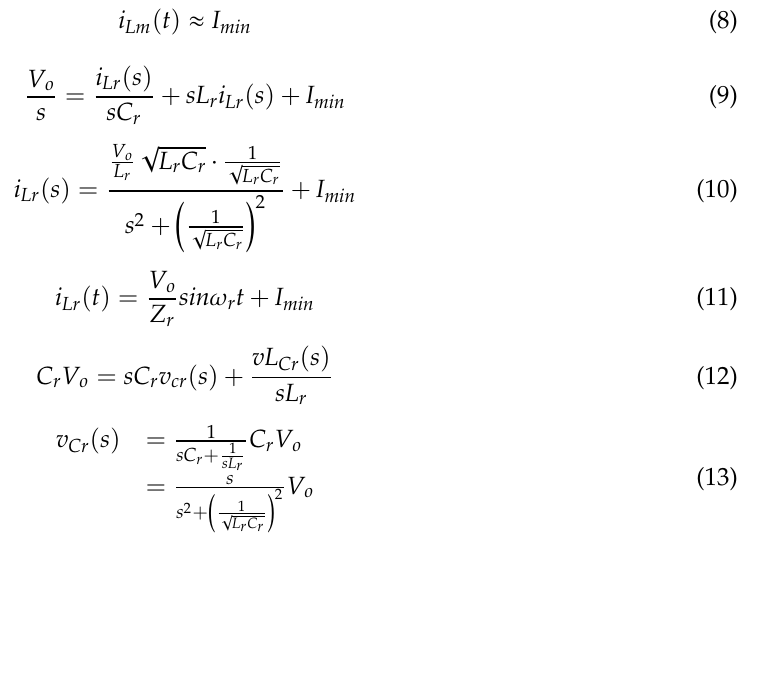
Figure 6. The equivalent circuit of Mode 3 and key waveform.